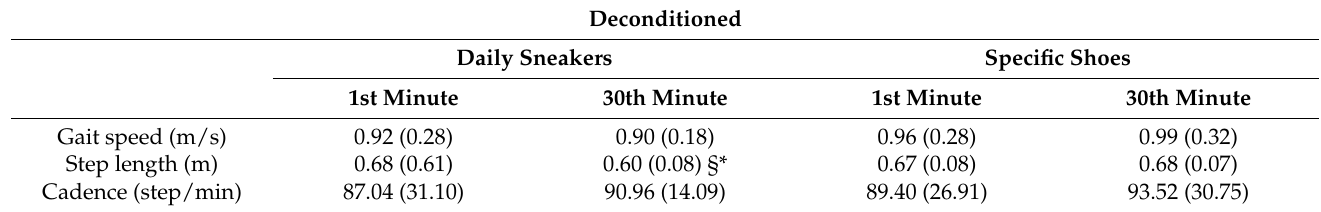
Table 4. Mean and standard deviation of parameters during the outdoor 30-min gait test for the deconditioned group during the early (1st minute) and last (30th minute) segment of the test during the two sessions (daily sneakers vs. specific shoes). * = p < 0.05, statistically significant in the post hoc comparison daily sneakers vs. specific shoes; § = p < 0.05, statistically significant in the post hoc comparison 1st minute vs. 30th minute.